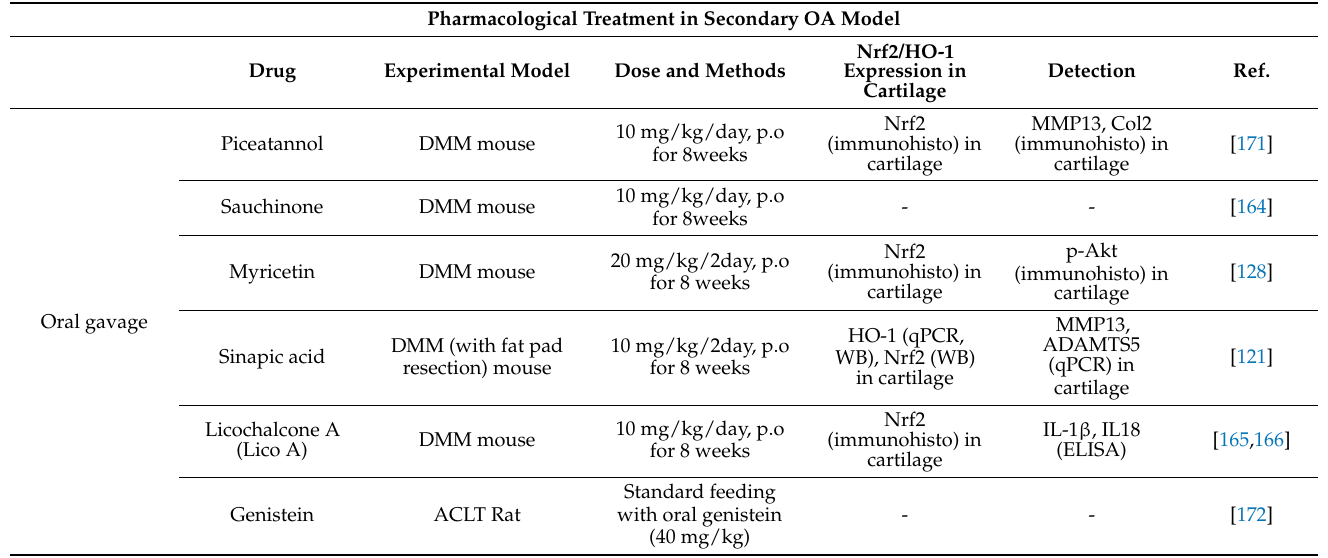
Table 4. Pharmacological treatment for OA by Nrf2/HO-1 induction in